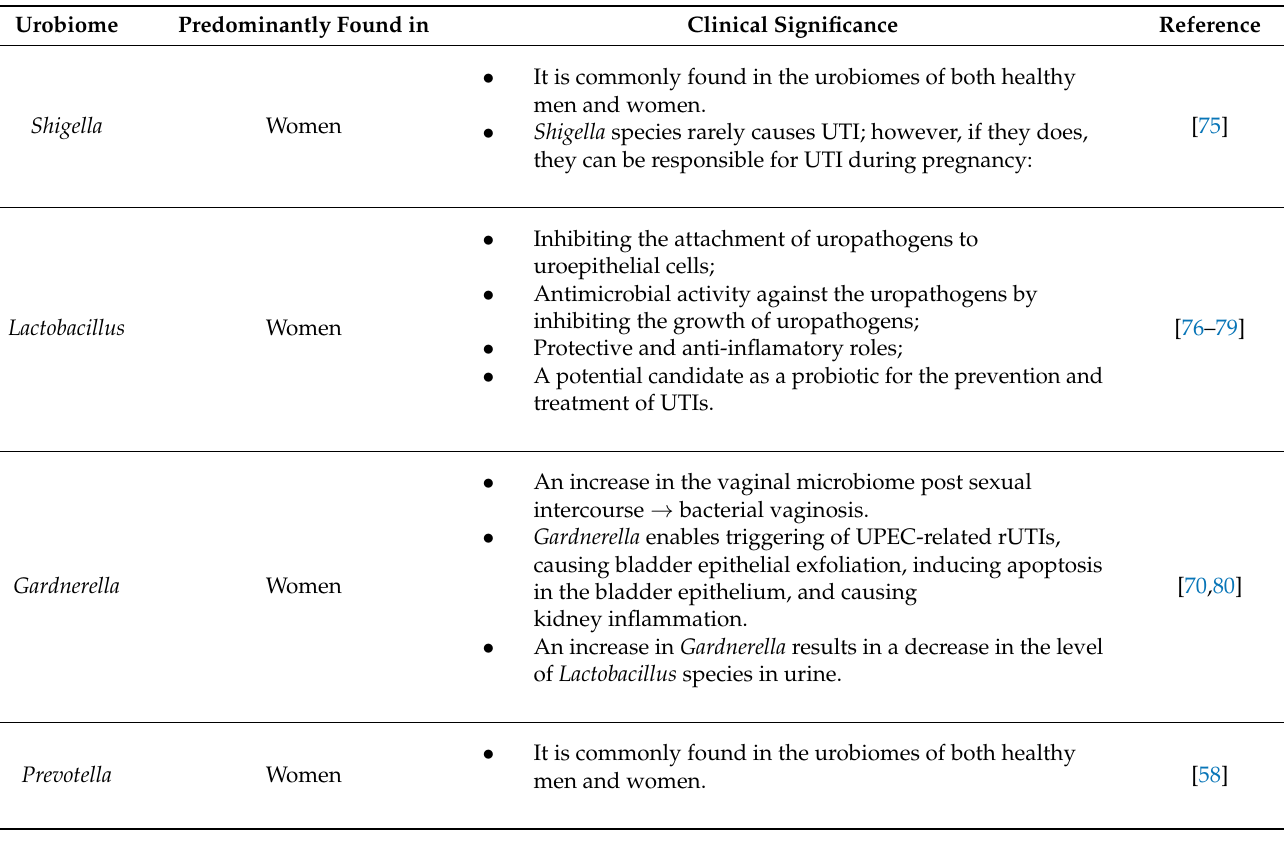
Table 5. Common urinary microbiome found in healthy women and men. Clinical Significance